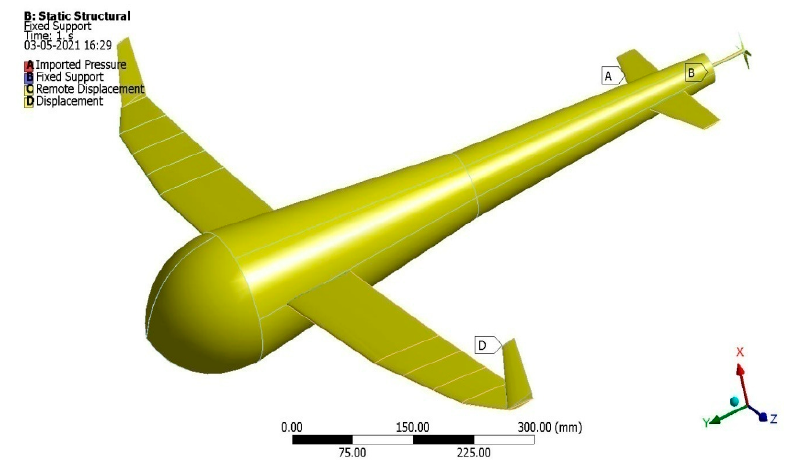
Figure 12. Meshed structure of UAV for HSI simulation.